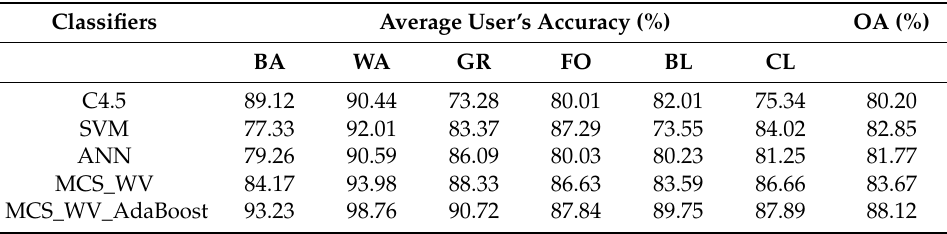
Table 5. Classification average user’s accuracy with different classification algorithms.